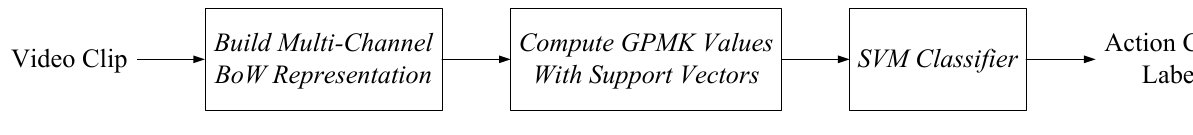
Figure 1. The flowchart of our kernel-based human action recognition